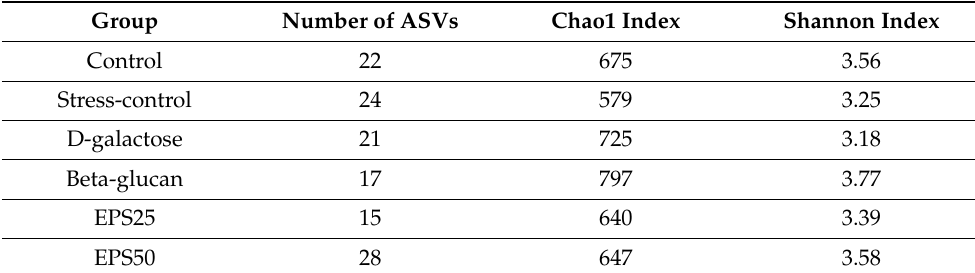
Table 2. Alpha-diversity analysis of the intestinal microbiota in mice. Group Number of ASVs Chao1 Index Shannon Index Control